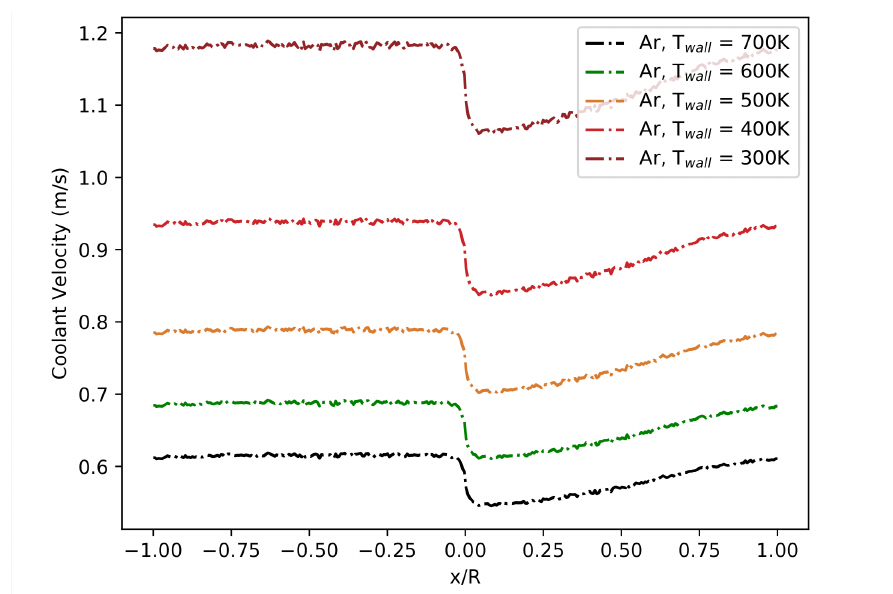
Figure 11. Coolant velocity variation along wall for Mach 10 argon flow when wall and porous domain temperature is